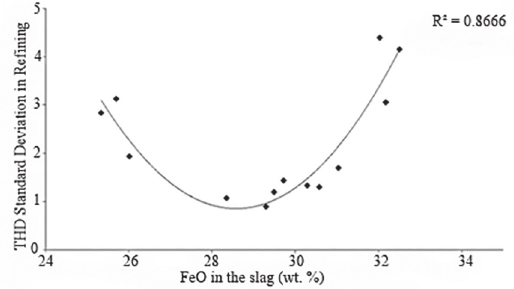
Figure 7: Relationship between the voltage standard deviation and the THD standard deviation. Note the linear relationship between the voltage standard deviation and the THD standard deviation of the EAF. This is due to the fact that the higher the instability of the arc, the greater the voltage deviation, and therefore the greater the voltage harmonics variation. Figure 8 shows the harmonics standard deviation relating with the FeO content, considering the FeO content between 25 and 32% and basicity between 2.4 and 3.2.